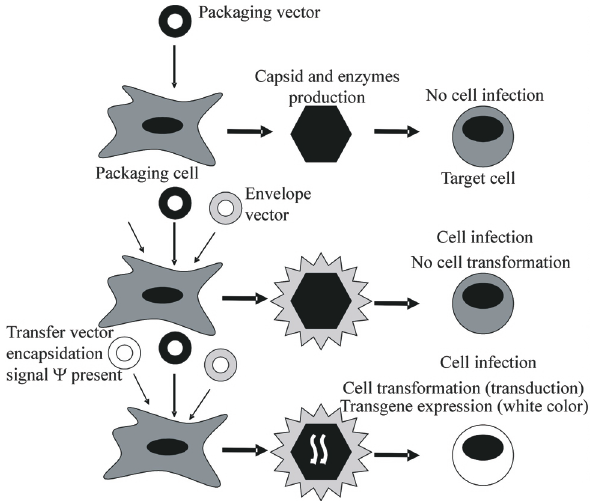
Figure 3 - Production of retrovectors by transient transfection (adapted from Silva, 2002). Packaging cell lines are transiently transfected with the vectors responsible for the assembly of recombinant viruses. In cases (A) and (B), retrovectors are not functional. Complete vectors able to infect and transduce target cells are produced only when the packaging cells are transfected with the three plasmids